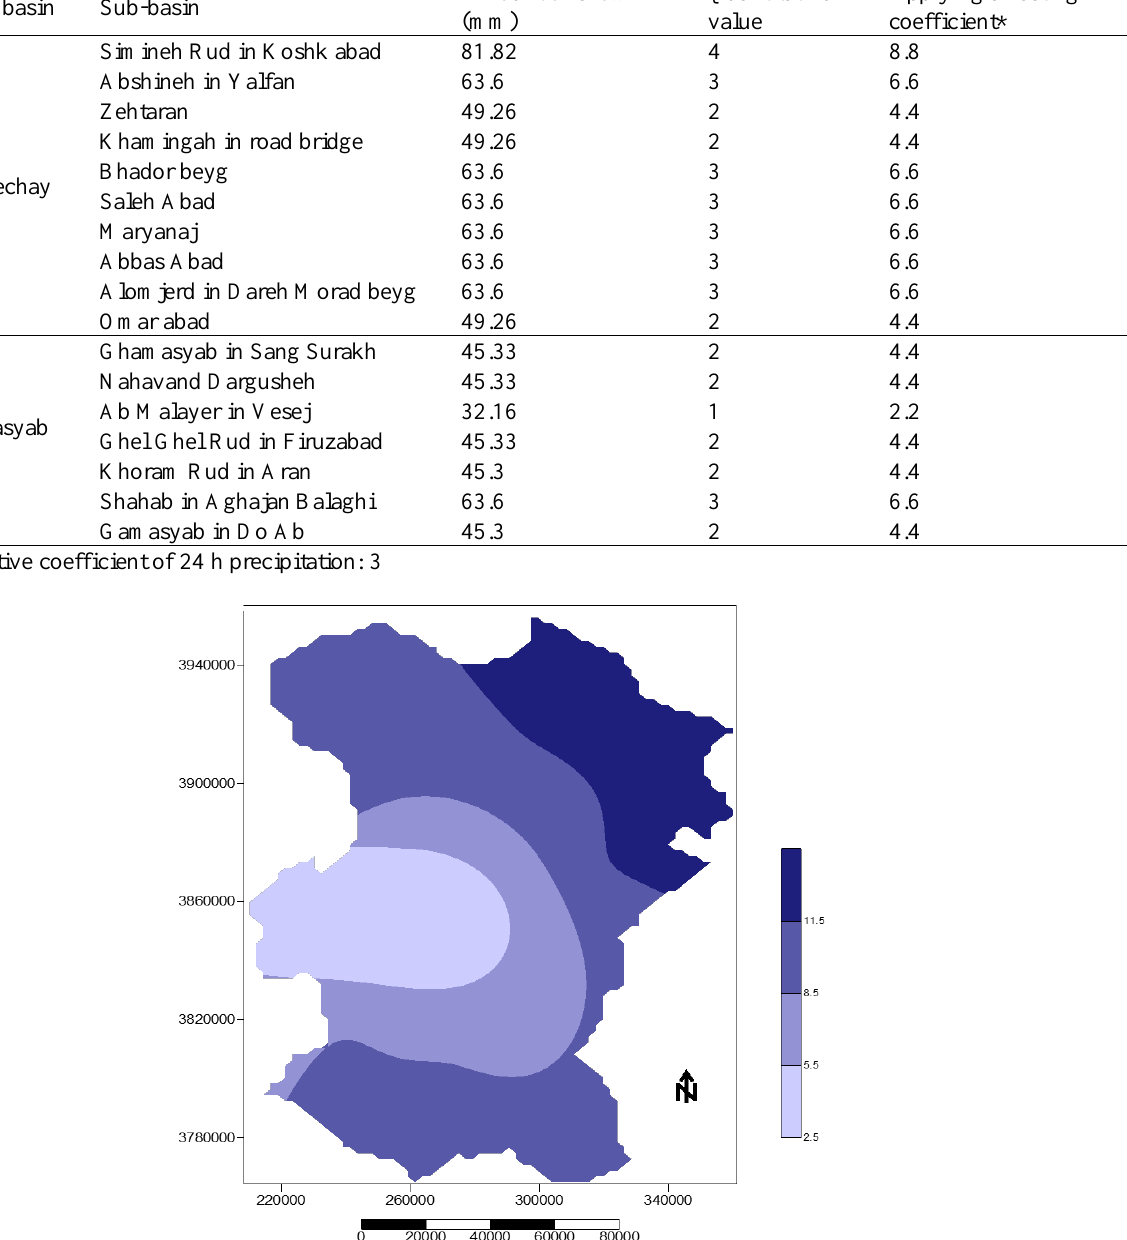
Quantitative Applying affecting coefficient*